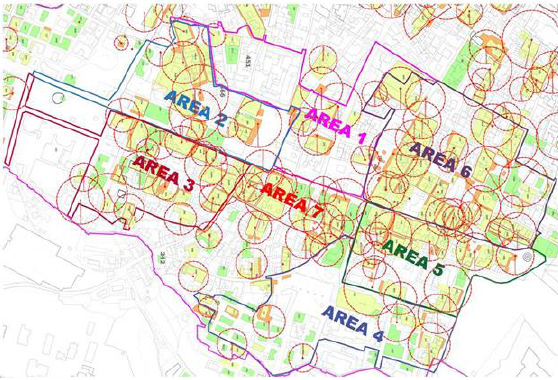
Figure 7. The image shows the division into seven areas of the urban built heritage affected by the works in Excerpt I. Within each of them, the dotted circles that represent the arm of the installed cranes are identified, while the yellow color indicates the reconstruction sites that were active in March 2016